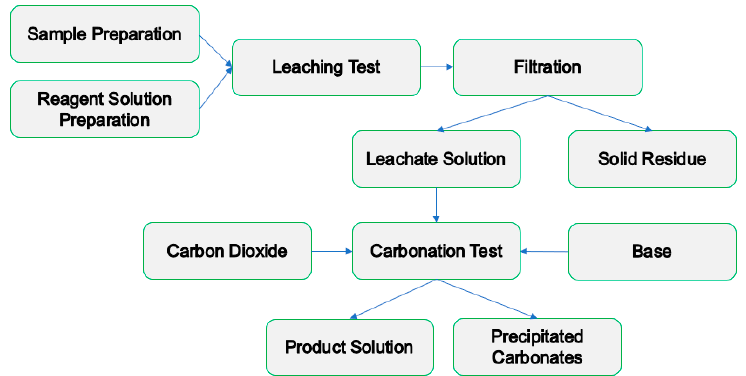
Figure 1. Block flow diagram of the mineral carbonation process employing the pH swing method.